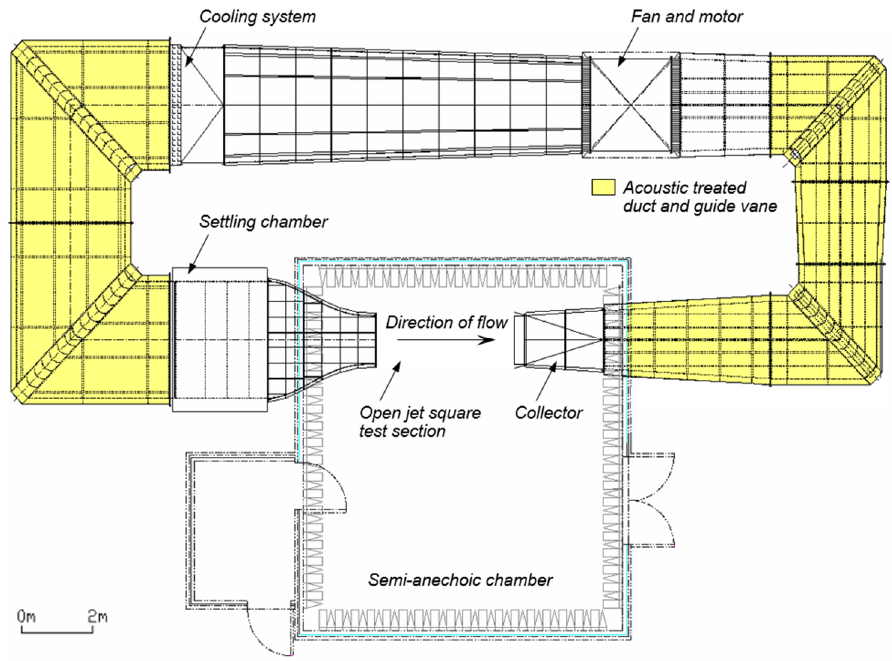
Figure 6. The layout of a semi-anechoic wind tunnel in Chungnam National University.